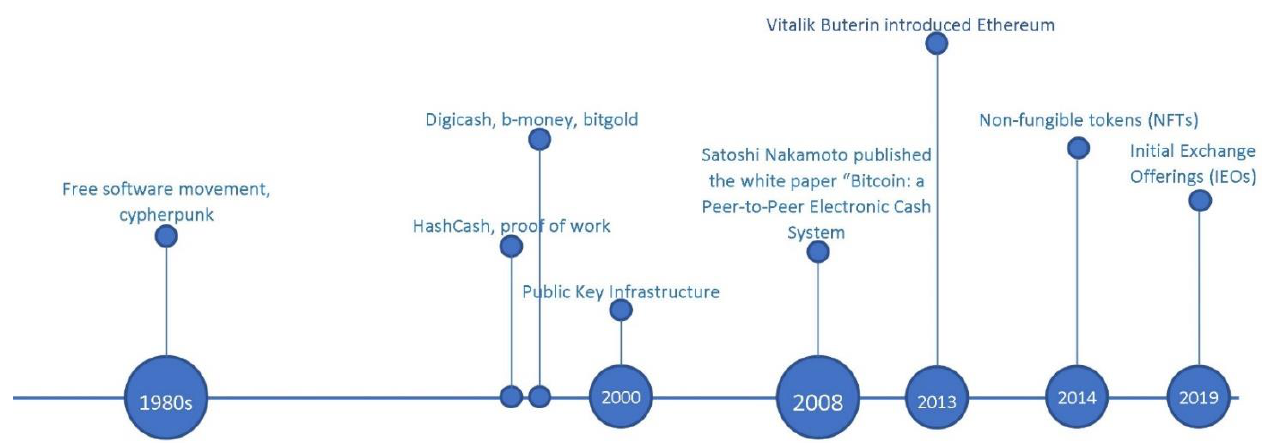
Figure 1. The Important Points on the Timeline of the Blockchain Evolvement.